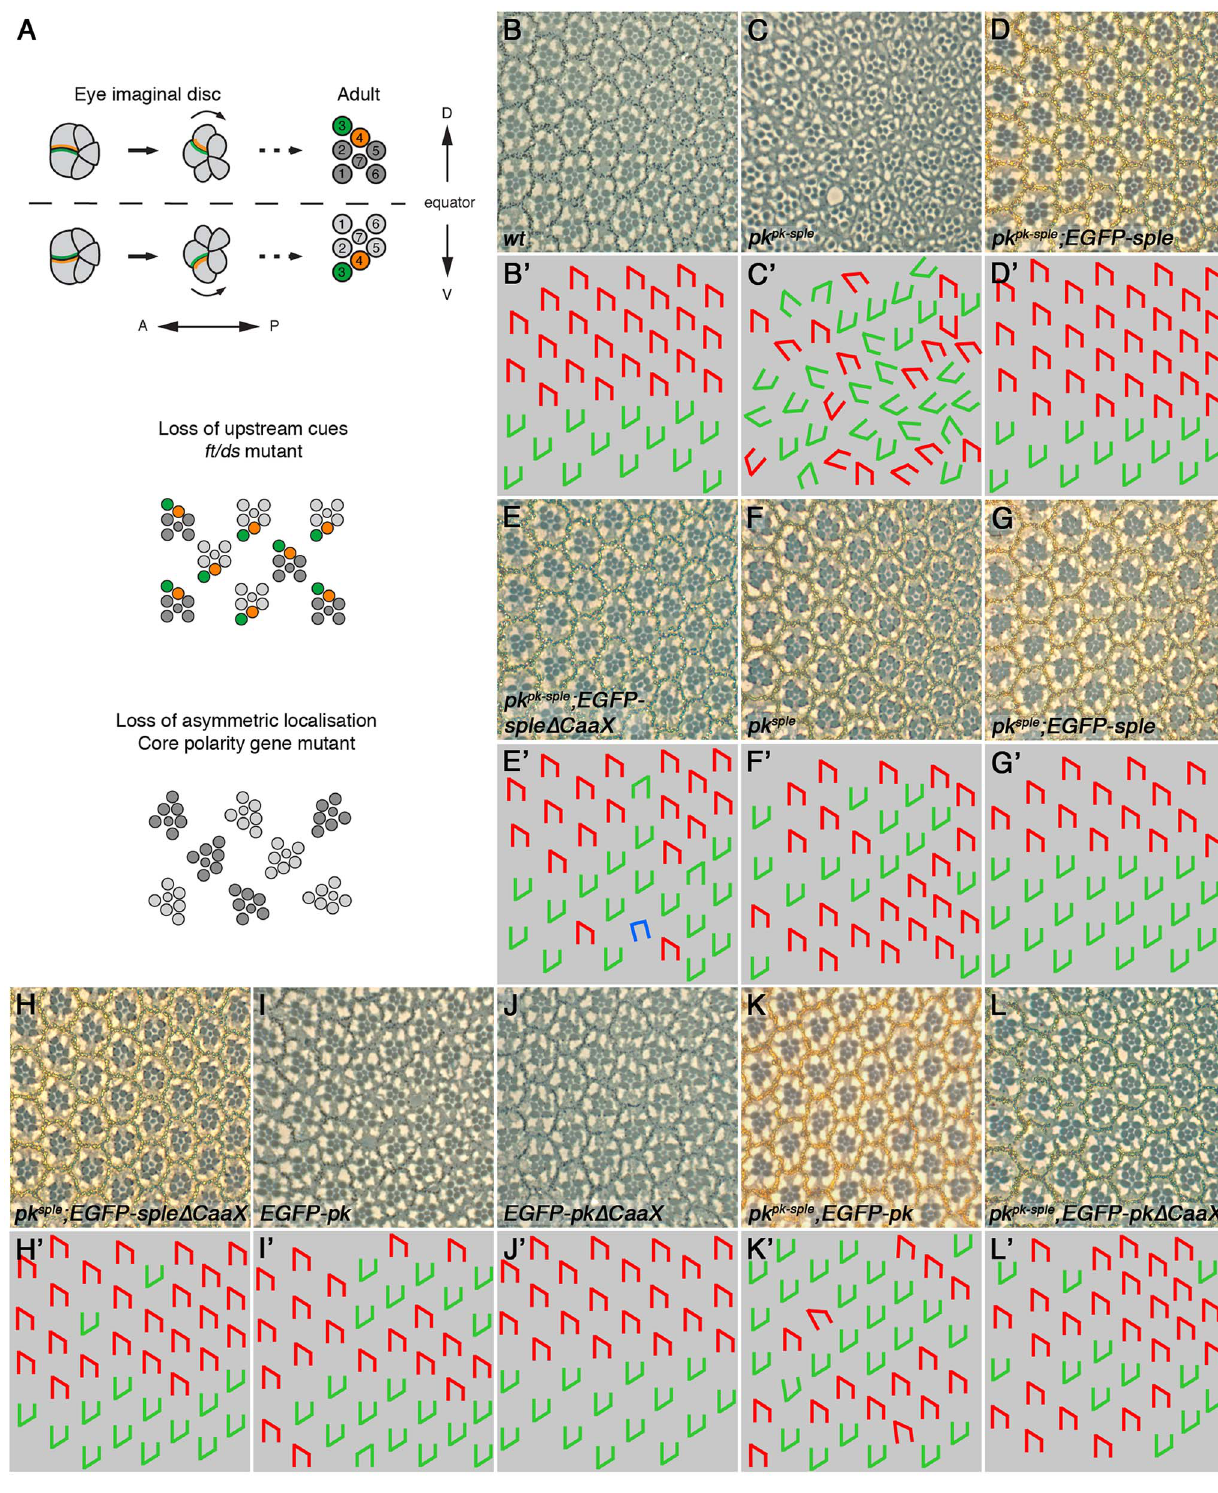
Figure 4. Partial requirement for Pk/Sple farnesylation in the eye. (A) Cartoon showing ommatidial polarity and rotation. In the eye imaginal disc, photoreceptor cells are recruited in a wave from posterior (P) to anterior (A). Photoreceptor cell clusters are initially symmetric, but Fz (green) becomes localised to the R3/R4 cell boundary, in the cell closest to the dorsal-ventral (DV) midline, or equator. Stbm/Sple (orange) localise to the apposing cell edge. This specifies R3/R4 cell fate, and causes ommatidia to adopt opposite chirality on either side of the equator, and to rotate 90 u in opposite directions. In eyes in which upstream cues have been lost, core proteins localise asymmetrically and rotate 90 u as normal, but the R3/R4 fate decision is randomised and ommatidia adopt random chirality. In core polarity gene mutants, asymmetric localisation of the other core proteins is lost or delayed, and ommatidia adopt random chirality and rotate to a random degree. (B–L) Adult eye sections (B–L), and cartoons (B’–L’), of a region around the equator from wild type (B), pk pk-sple13 (C), pk pk-sple13 ; ActP - EGFP-sple/ + (D), pk pk-sple13 ; ActP - EGFP-sple D CaaX/ + (E), pk sple1 (F), pk sple1 ; ActP